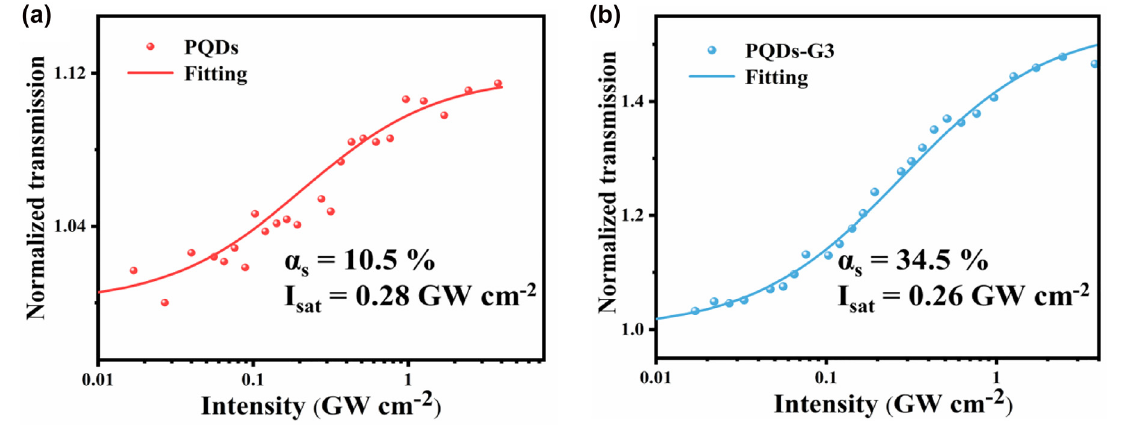
Figure 6: Normalized transmission versus input intensity of PQDs (a) and PQDs-G3 (b).